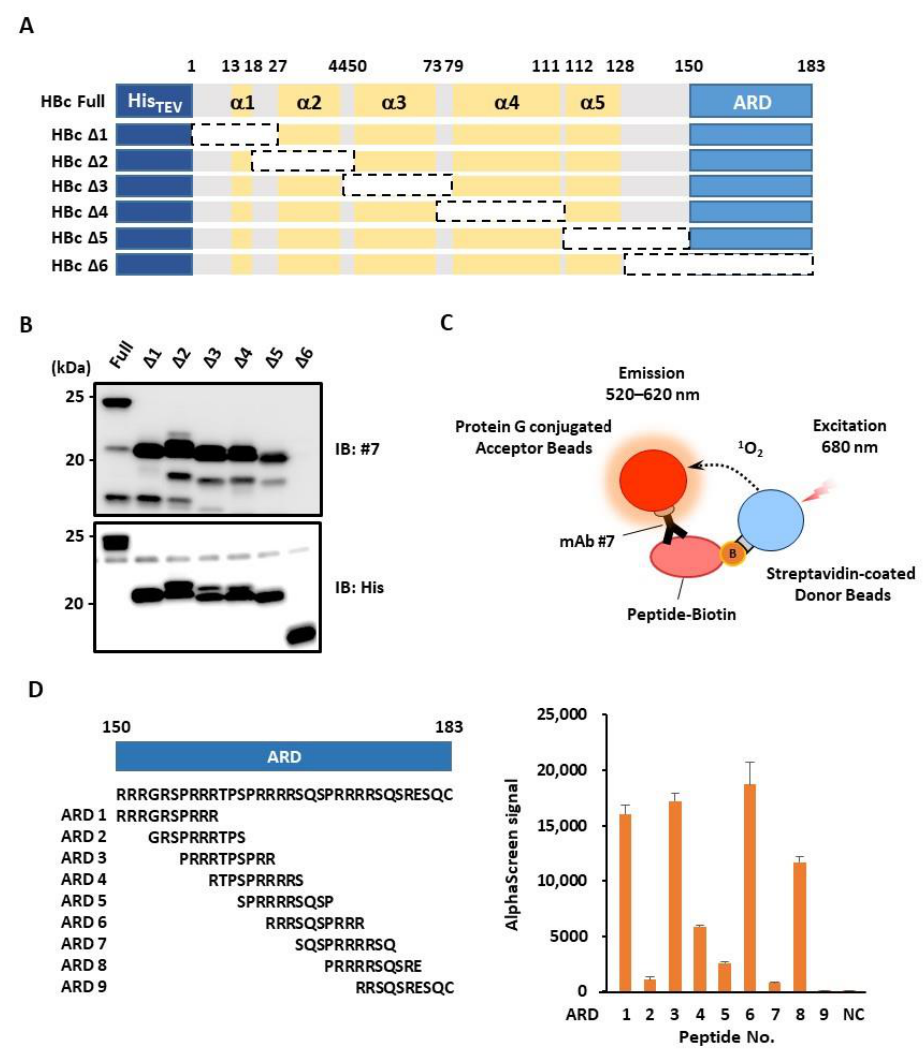
Figure 3. Epitope mapping for the newly developed mAb #7. ( A ) Schematic of a full-length HBc and six deletion mutants (HBc ∆ 1–6). These N-terminal His-tagged proteins were produced using a wheat germ cell-free system. ARD, arginine-rich domain. ( B ) His-HBc and its deletion mutants were analyzed by immunoblotting using mAb #7 or anti-His antibody. ( C ) Schematic of the AlphaScreen assay. Protein G-conjugated acceptor beads and streptavidin-conjugated donors were used to monitor the interaction of mAb #7 with the synthesized peptides. ( D ) AlphaScreen assay. Nine biotin-tagged ARD peptides (ARD1–9) were synthesized (left panel). The binding activity was measured as the level of the AlphaScreen luminescence signal (right panel). Error bars represent standard deviations from three independent experiments. NC, negative control.